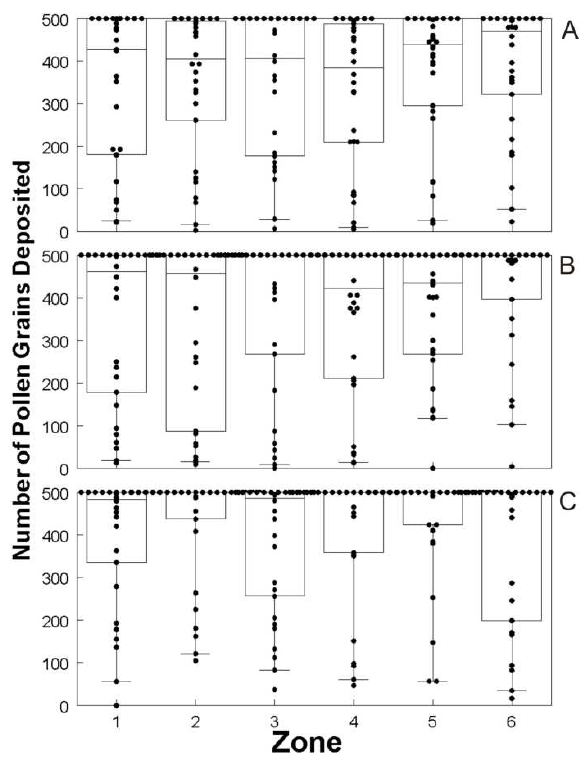
F IGURE 5. Pollen deposition per whole flower (box and whisker plot, central horizontal line showing mean, box = 25 th and 75 percentiles, whiskers = 5 th and 95 th percentiles) during A) early, B) mid, and C) late flowering of 2001. Zone 1 is closest to Osmia nests, Zone 6 most distant. Significant differences were observed among stages of flowering but not among the zones; a significant interaction between flowering period and zone was not observed (see